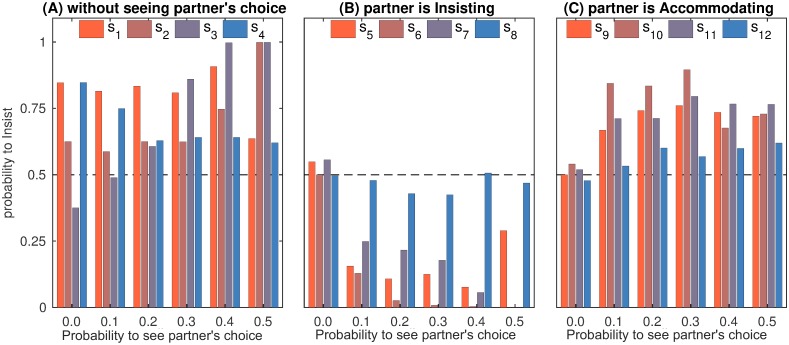
i(A)CG strategies in the final population.Strategies are taken for the 109-th generation and averaged over 80 runs. This figure characterizes the final population as a whole and complements Table 2 representing specific strategies. (A): Strategy entries s1, …, s4. The decrease of the s2/s3 ratio reflects the transition of the dominant strategy from challenging to turn-taking for psee = 0.0, …, 0.4. For psee = 0.5 the dominance of the Leader-Follower strategy is indicated by s2 = s3 = 1. (B) Entries s5, …, s8 are irrelevant for psee = 0. Values of s6, s7 decrease as psee increases, indicating an enhancement of cooperation in i(A)CG for higher transparency (s8 is almost irrelevant since mutual accommodation is a very rate event, and s5 is irrelevant for a population of L-F players taking place for psee = 0.5). (C) Entries s9, …, s12 are irrelevant for psee = 0. The decrease of the s10/s11 ratio for psee = 0.1, …, 0.4 reflects the transition of the dominant strategy from challenging to turn-taking.